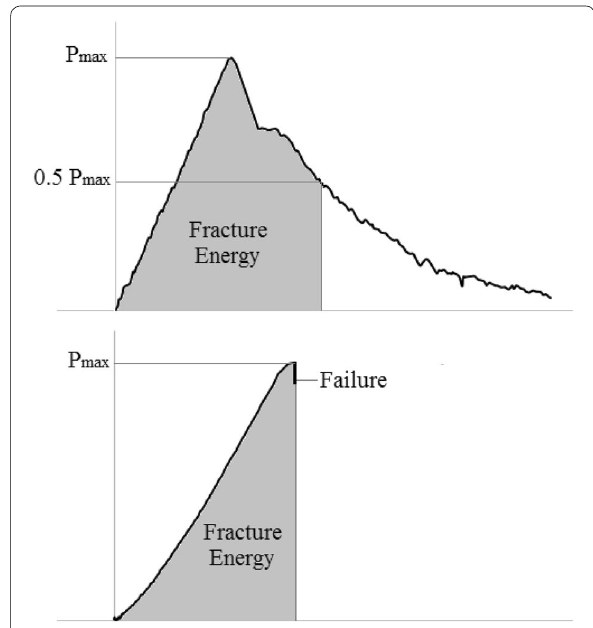
Fig. 9 Schematic load–deflection curves to define the measured fracture energy.